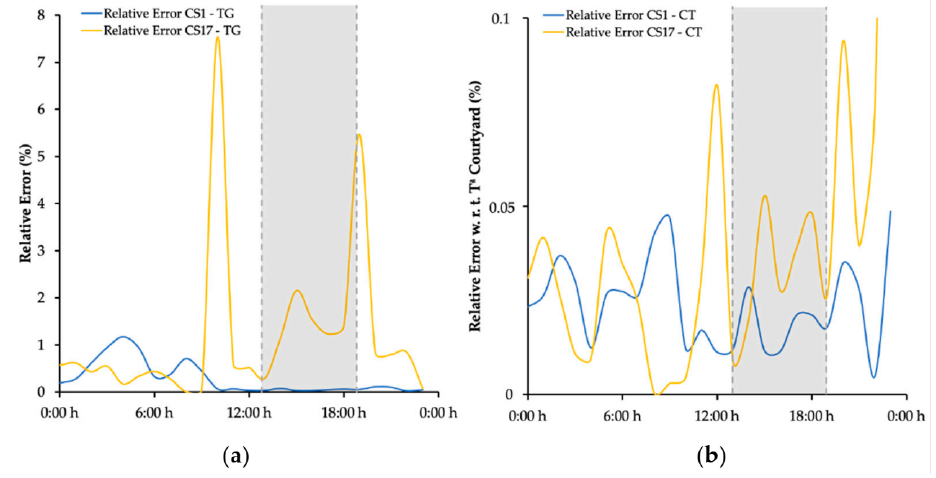
Figure 9. Relative errors CS1 and CS17 according to: ( a ) TG ( b )